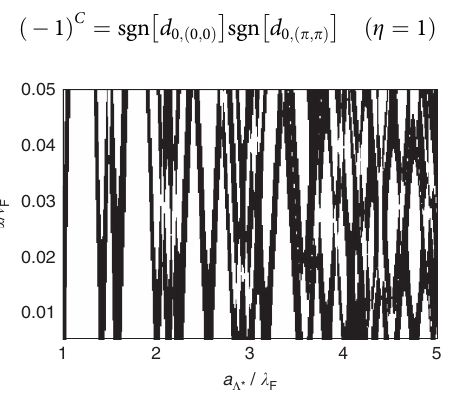
Figure 3 | Phase diagram in the dilute impurity limit. Parity of the Chern number (white for even and black for odd) for the Bogoliubov-de Gennes band structure of an s -wave superconductor decorated with dilute Shiba impurities, following equation (14). Here the spin-orbit coupling strength a is scaled by the Fermi velocity v F , and the lattice spacing of the Shiba impurities a L * is scaled by the Fermi wavelength l F . Both v F and l F are taken in the limit a - 0 and we have assumed the superconducting coherence length x ¼ 30 l F